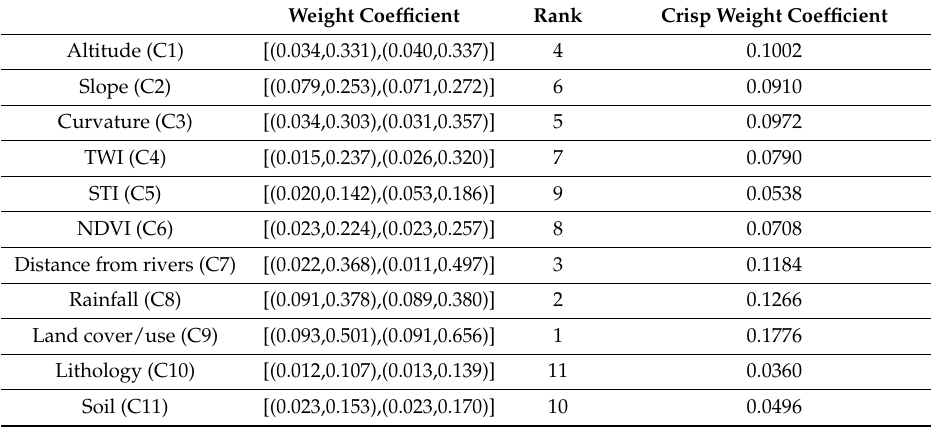
Table 7. Weight coefficients of the conditioning factors.Conditioning